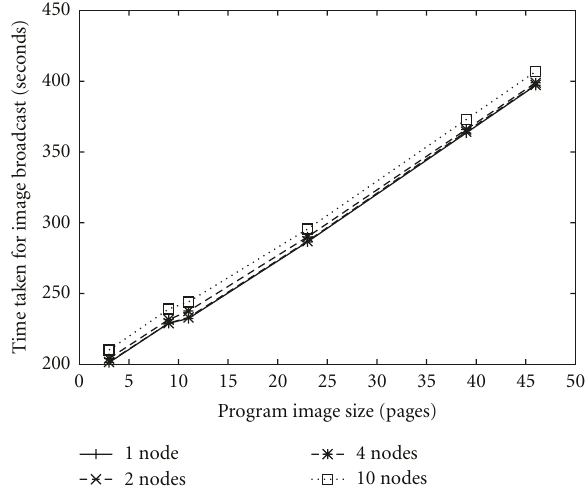
Figure 8: Transfer time from Base Station to multiple